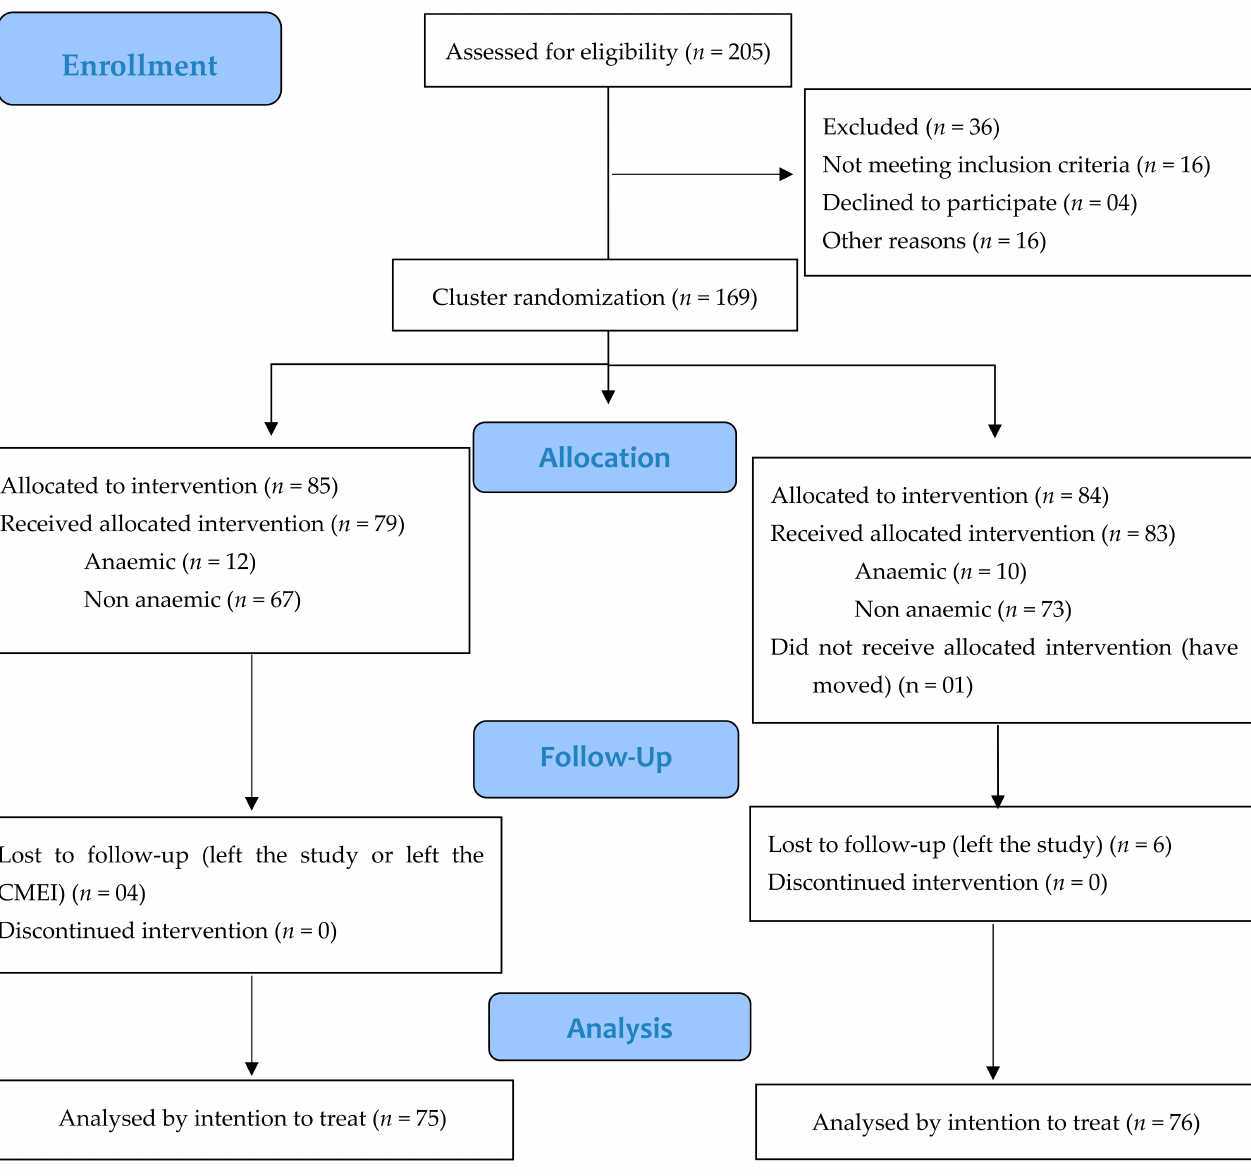
Figure 1. Profile of this randomized clinical trial. The Early Childhood Education Center (CMEI) that received allocation for multiple micronutrients powder (MNP) in a health district had its peer in the same health district receiving ferrous sulphate and folic acid (FS_FA), defined by lot, totaling 10 CMEIs (5 MNP and 5 FS_FA). Within each of these CMEIs, if children were anaemic, they received the dose corresponding to the anaemia treatment recommendation, and if they were not anaemic, they received the dose corresponding to the prevention of anaemia. The number of children included in the intention-to-treat analysis corresponded to those for whom initial and final hemoglobin levels were